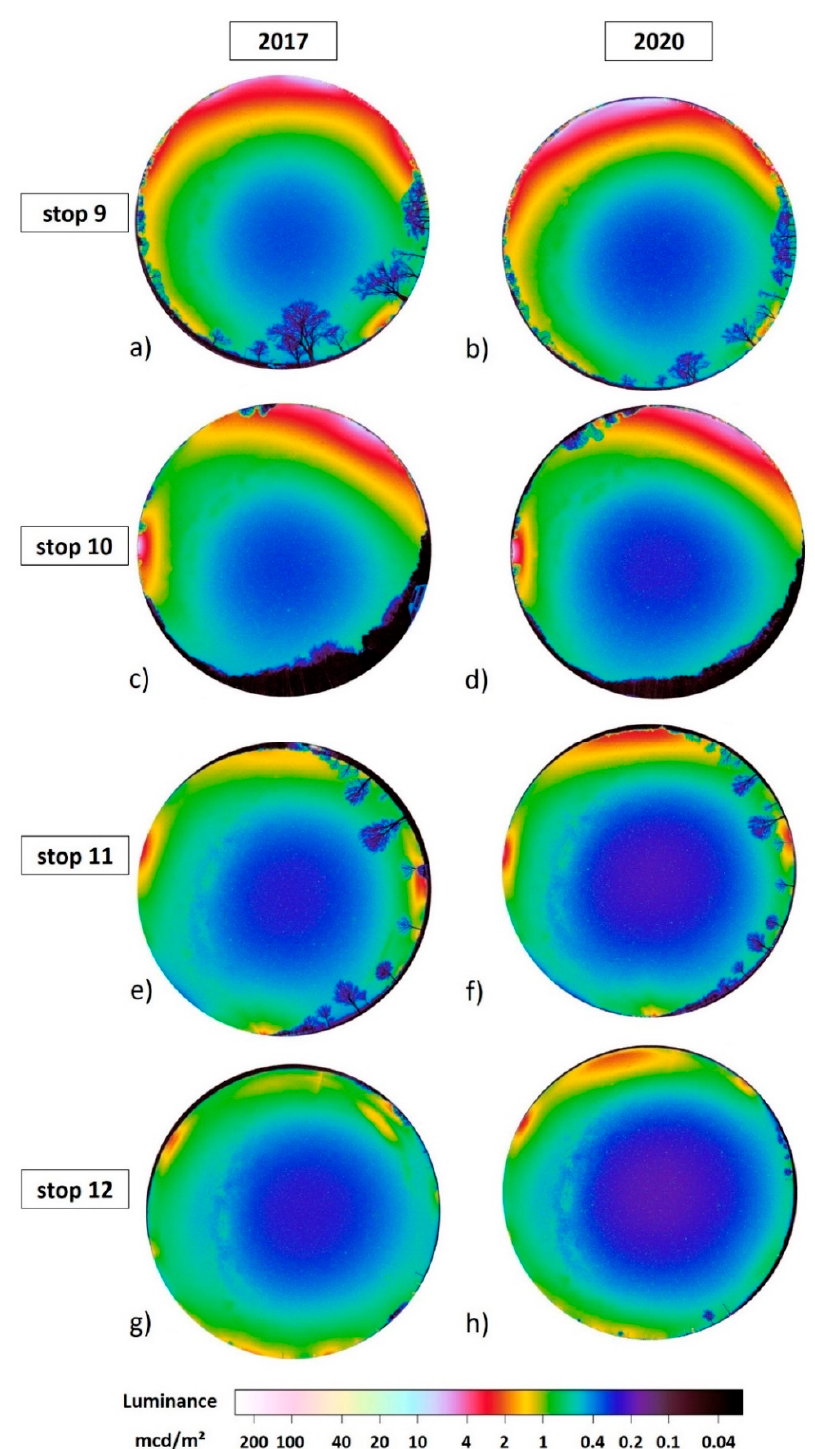
Figure A3. Luminance maps for stops 9–12. ( a , c , e , g ) 2017 data, ( b , d , f , h ) 2020 data.